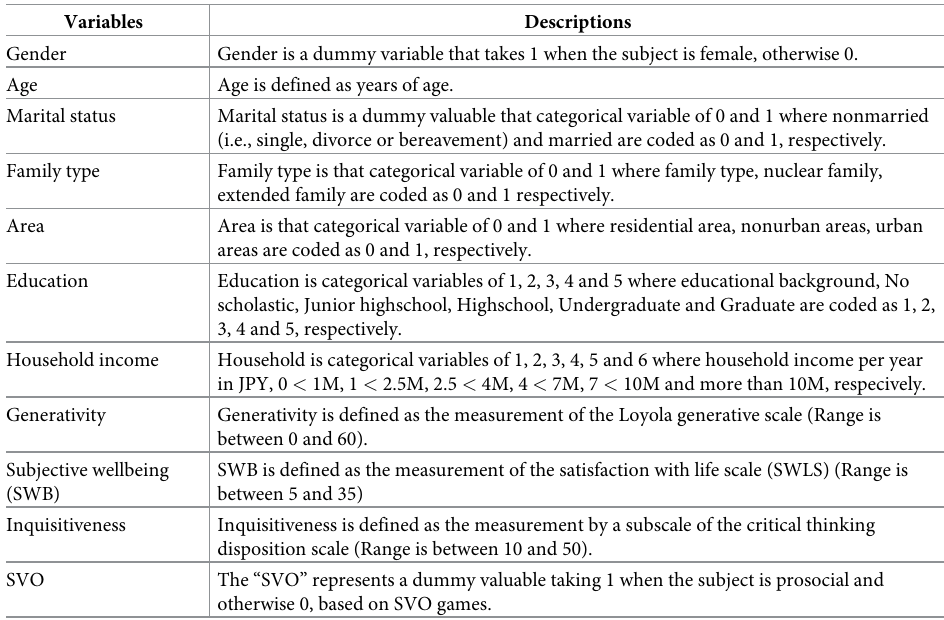
Table 1. Variable definitions.